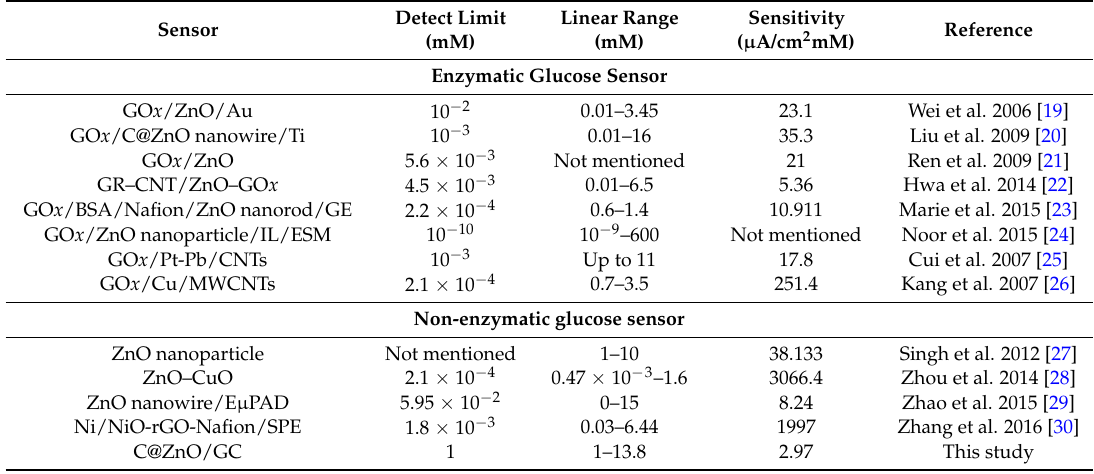
Table 1. Important performance of enzymatic and non-enzymatic glucose sensors are